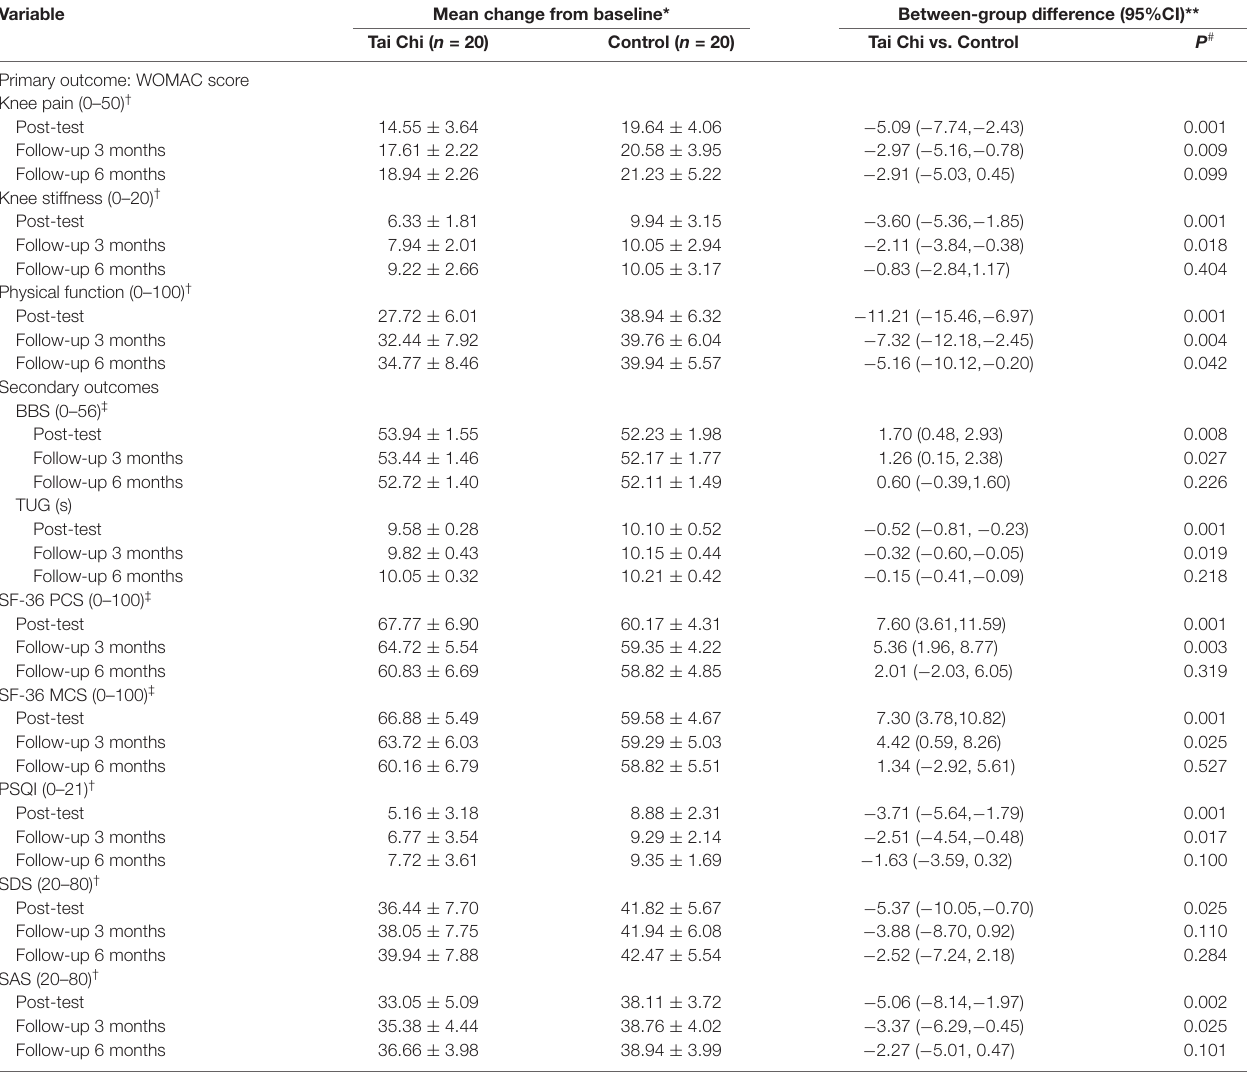
TABLE 2 | Primary and secondary outcomes. Variable Mean change from baseline* Between-group difference (95%CI)** Tai Chi ( n = 20) Control ( n = 20) Tai Chi vs. Control P